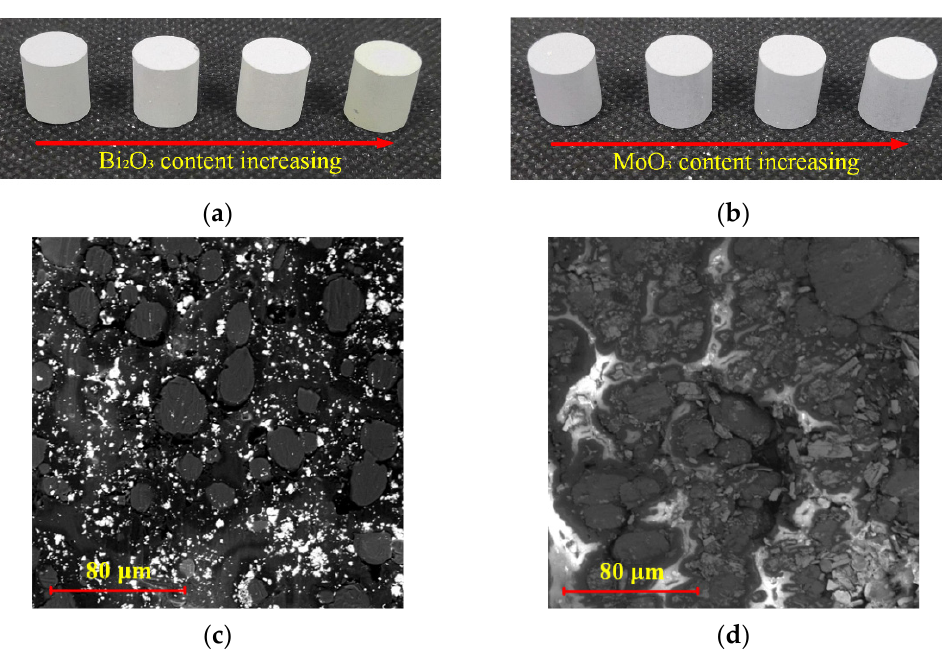
Figure 1. Typical sample ( a ) PTFE/Al/Bi 2 O 3 with Bi 2 O 3 content ranging from 10% to 40%; ( b ) PTFE/Al/MoO 3 with MoO 3 content ranging from 10% to 40%; ( c ) SEM of PTFE/Al/Bi 2 O 3 (57.10/22.90/20); ( d ) SEM of PTFE/Al/MoO 3 (53.29/26.71/20).